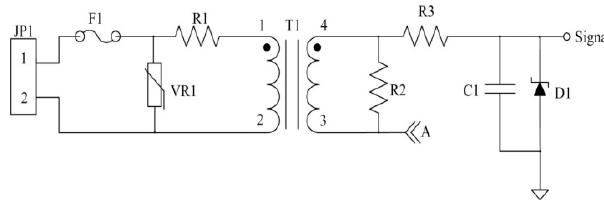
Figure 1. Voltage signal isolating circuit.